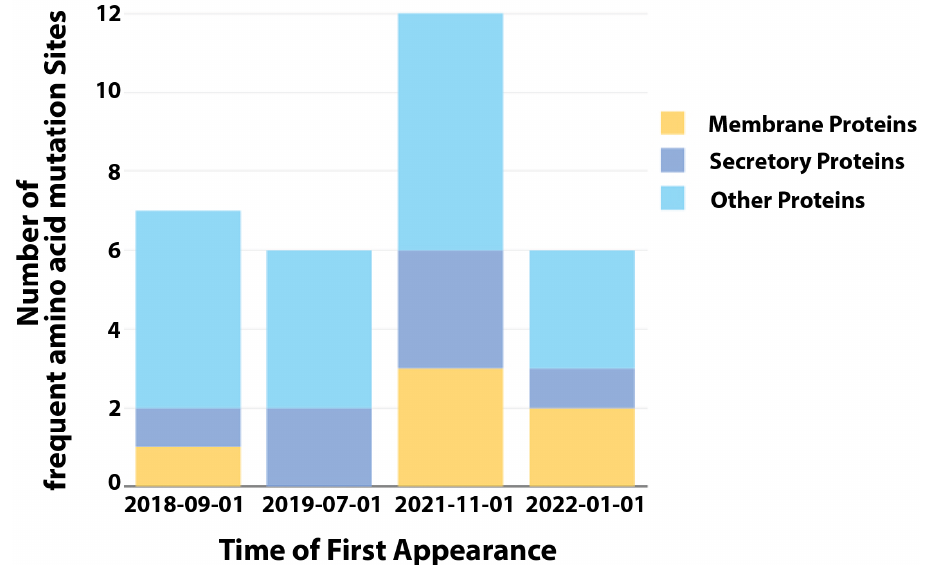
Figure 3. The incidence of frequent amino acid mutations. The frequency of the appearance of SNPs in different months in 2022 was analyzed and 31 frequent non-synonymous mutations were found. The frequent amino acid mutations were clustered into four groups based on their dates of first appearance, which were determined through evolutionary analysis. The mutations located in dif- ferent viral proteins are indicated by colors. The data of record numbers are sourced from Table 1. Table 2. Frequent amino acid mutations.